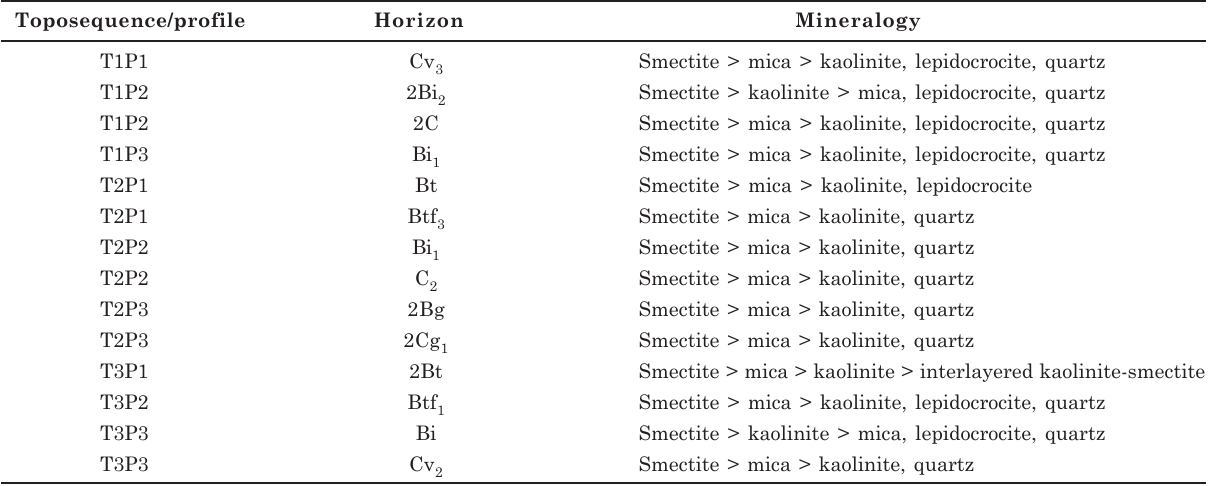
Table 4. Estimates of the relative proportions of the mineral constituents of the clay fraction of the analysed horizons